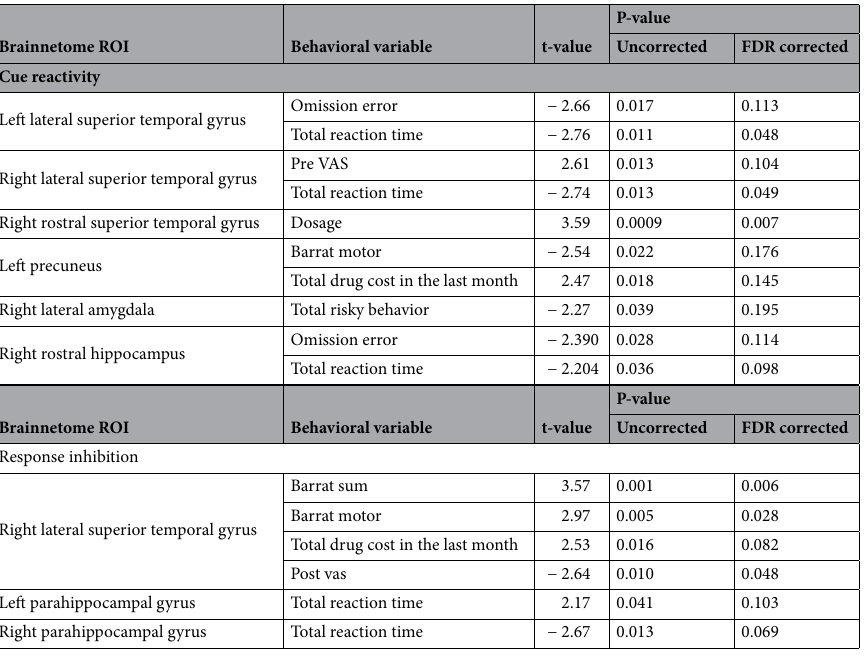
Table 3. Results of t-tests between groups with positive interaction β values from linear model, and groups with negative β values in the cue reactivity and response inhibition contrasts. There were no significant regions in the methamphetamine-related response inhibition